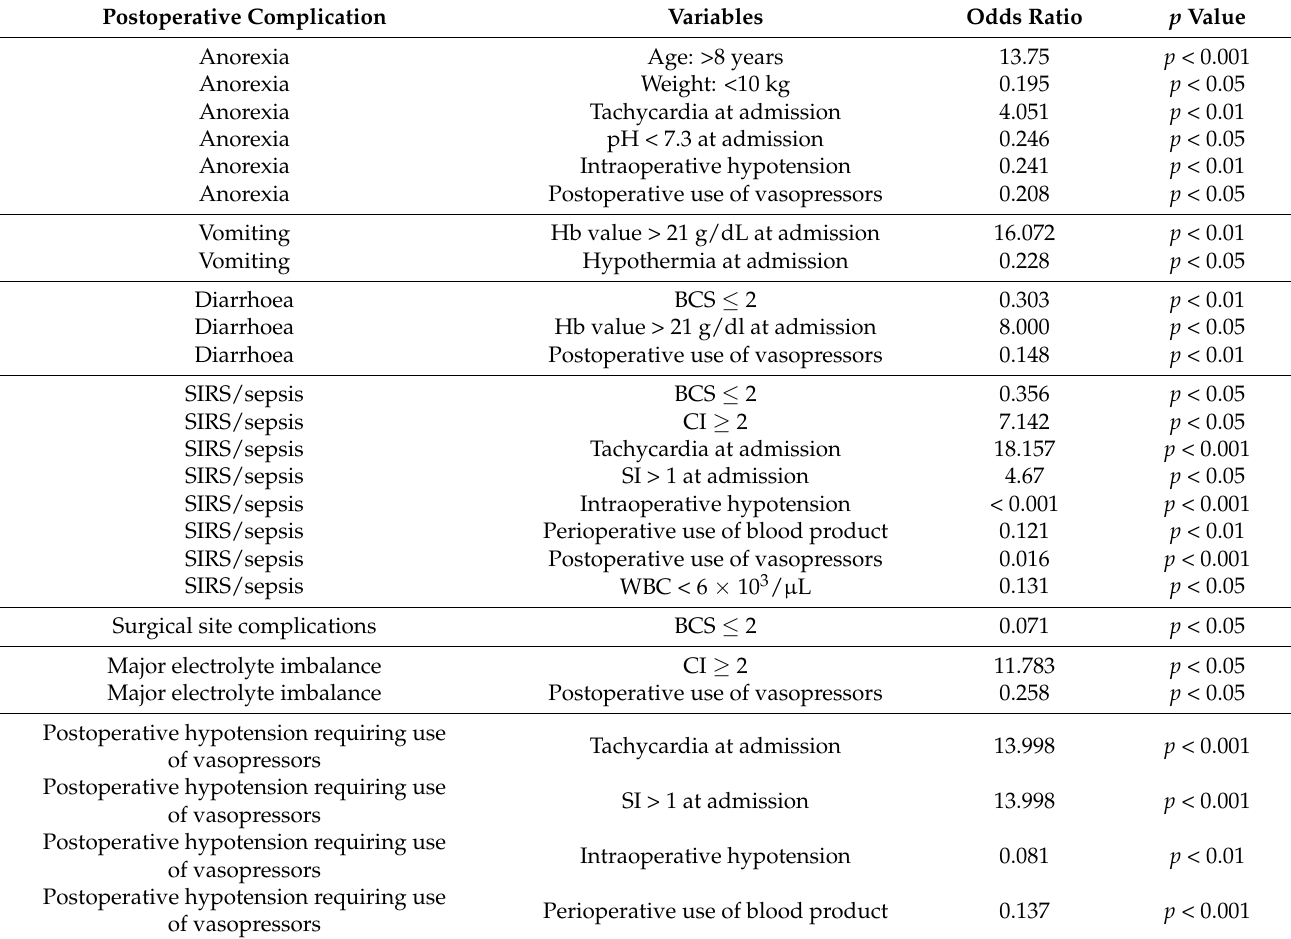
Table 6. Risk factor analysis for postoperative